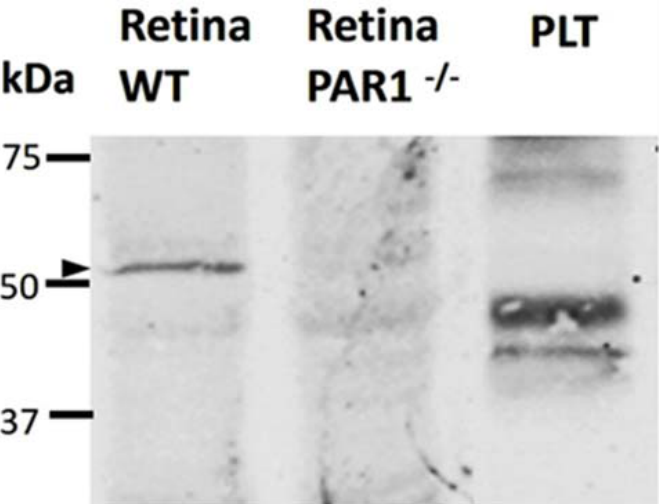
Figure 4. Western blot analysis with PAR1 antibody confirmed the specificity of antibodies. Western blot analysis was performed with the same antibody used for immunofluorescence analysis (NBP- 71770, Novus biologicals). A ~52 kDa protein was detected (indicated by an arrow) in lysates of retinas derived from C57BL/6J mice but not from PAR1 knockout mice (PAR1 − / − ) nor in mouse platelets (PLT). The uncropped membrane is presented in Supplementary Figure S1.